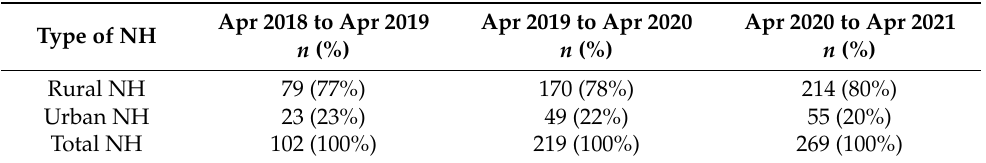
Table 1. Distribution of the teleconsultations during the three-year period according to the type of nursing homes (rural or urban).